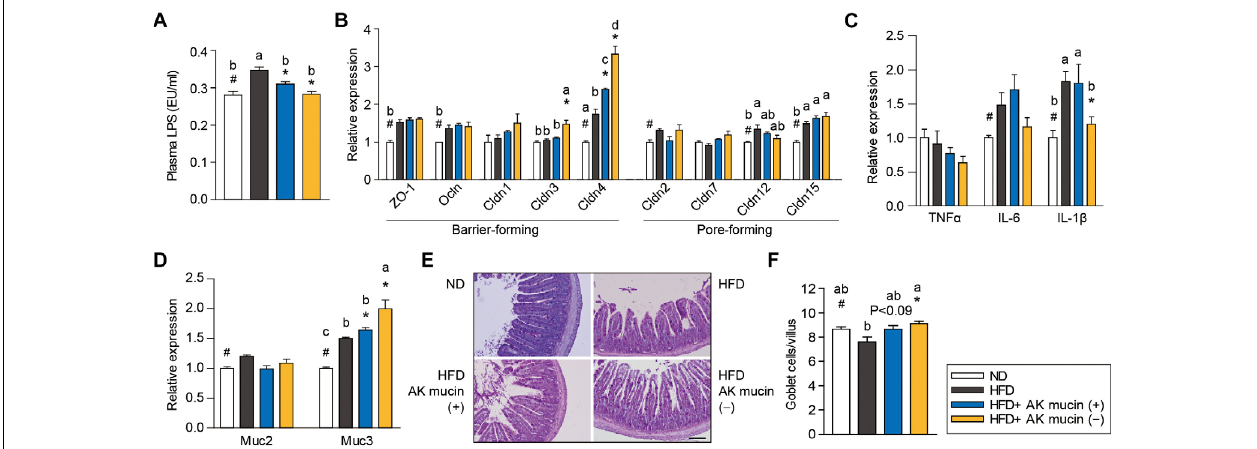
FIGURE 5 | Effects of A. muciniphila on intestinal barrier function and inflammation. (A) Circulating plasma LPS measured after 4 weeks of treatment. (B) Expression of genes encoding barrier- or pore-forming tight junction proteins, (C) proinflammatory cytokines, and (D) mucin in the ileum. (E) Representative PAS-stained images and (F) mucus-containing goblet cell density in the ileum. Scale bars, 100 µ m. Data are means ± SEM ( n = 4–5 for each group). # P < 0.05, High fat diet (HFD) vs. Normal chow diet (ND) group, ∗ P < 0.05, HFD vs. A. muciniphila -treated group (two-tailed Student’s t -test). abc Means not sharing a common letter are significantly different at P < 0.05 (Tukey-Kramer HSD